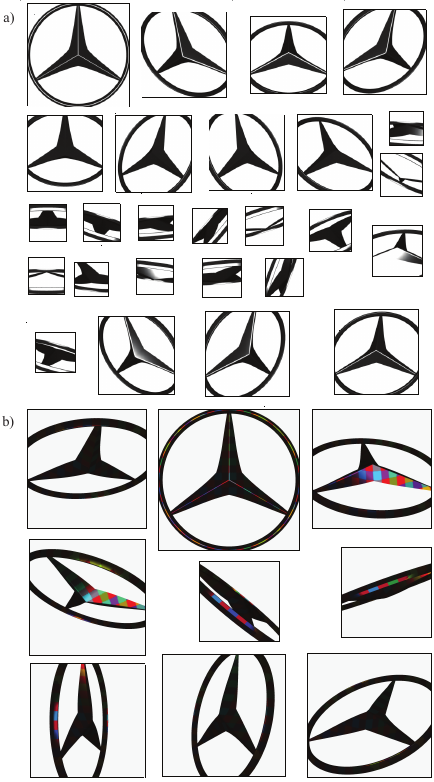
Figure 17. Images of a metallic logo to be inspected using the reference lighting ( a ) and the function ‘ Interlaced XY ’ ( b